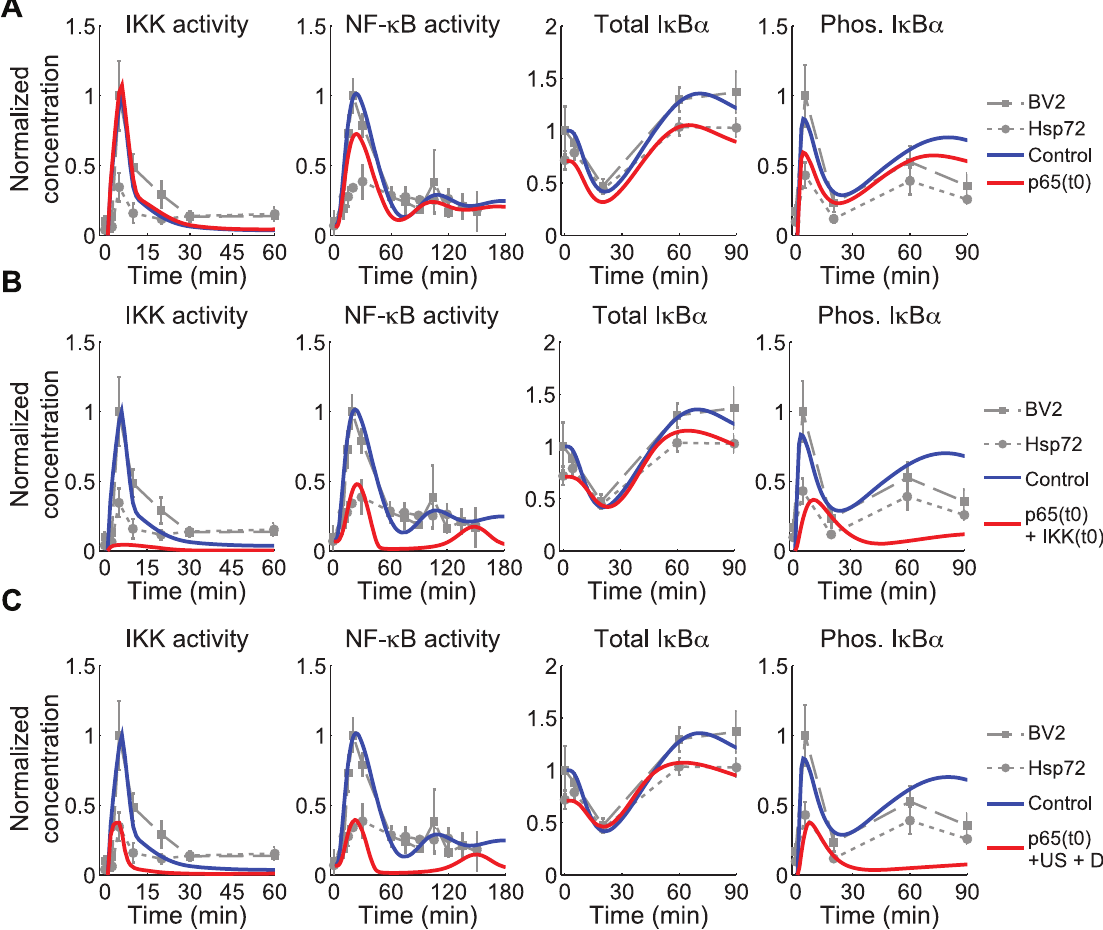
Figure 5. Model suggests plausible scenarios for Hsp72 regulation require both reduction of p65 and IKK inhibition. A. Dynamic simulations of model with p65 protein reduced to 70% (p65(t0)) show that reduction in total NF- k B partially accounts for the attenuated dynamics observed in Hsp72 expressing cells, but completely fails to account for reduction in IKK activity. B. Combining reduced p65 protein with a reduction in total IKK protein (to 5.5% of nominal levels) reduces peak IKK and NF- k B activation levels similar to experiments, suggesting the combined effect is one plausible scenario of interaction. C. The model with reduced p65 protein and interactions upstream (US, increasing inactivation rate kiA20 10- fold) and downstream (DS, simulated by decreasing I k B a phosphorylation rate, kc2a , by 6-fold) also match many qualitative features of the model. Gray lines are data renormalized such that basal IKK and NF- k B activity in BV2 cells is 10% of maximum.